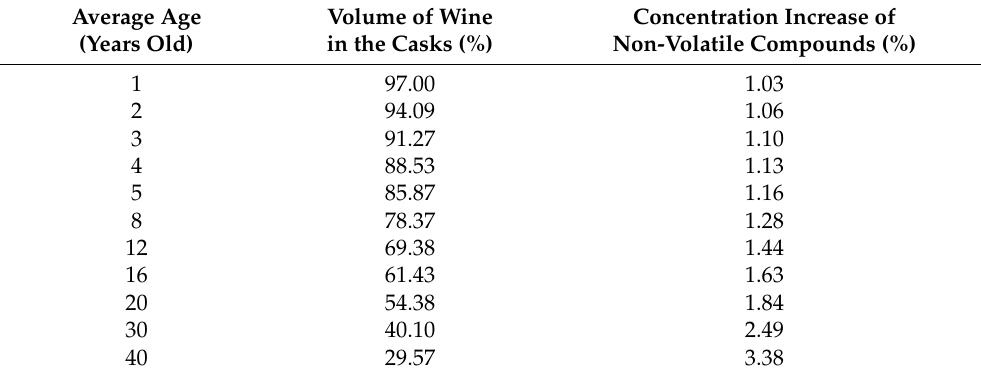
Table 3. Effect of a merma of 3% in volume with aging for the different average aging times studied. Data extracted from the reference